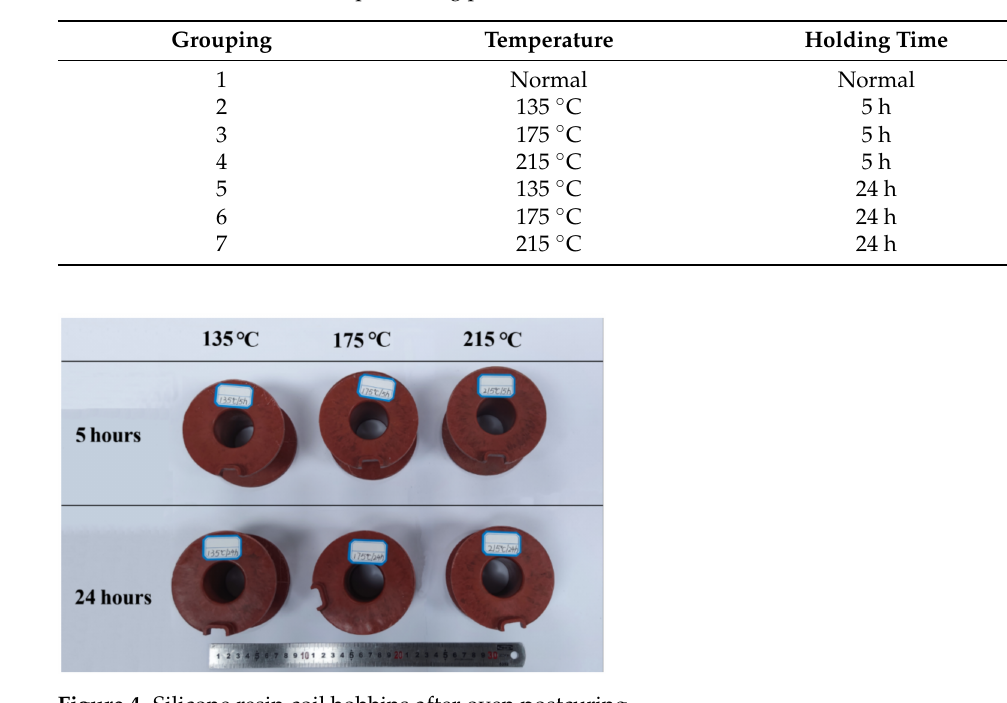
Figure 3. Compression-molded FRSR coil bobbin. ( a ) By process parameters recommended with the raw material supplier. ( b ) Process parameters optimized based thermal analysis tests. Table 3. The coil bobbin oven postcuring parameters.